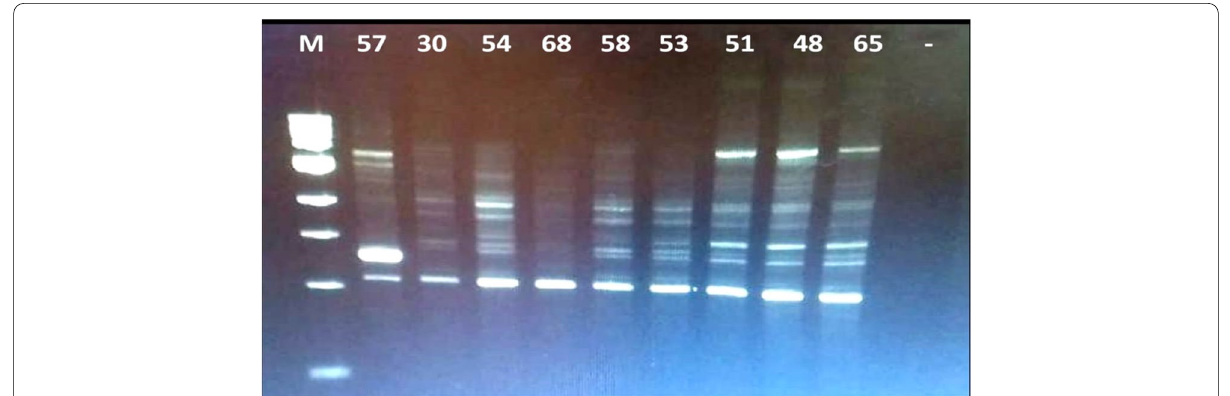
Fig. 2 BOX-PCR fingerprints of 9 bacterial isolates obtained from salted whey; M, 1Kb ladder